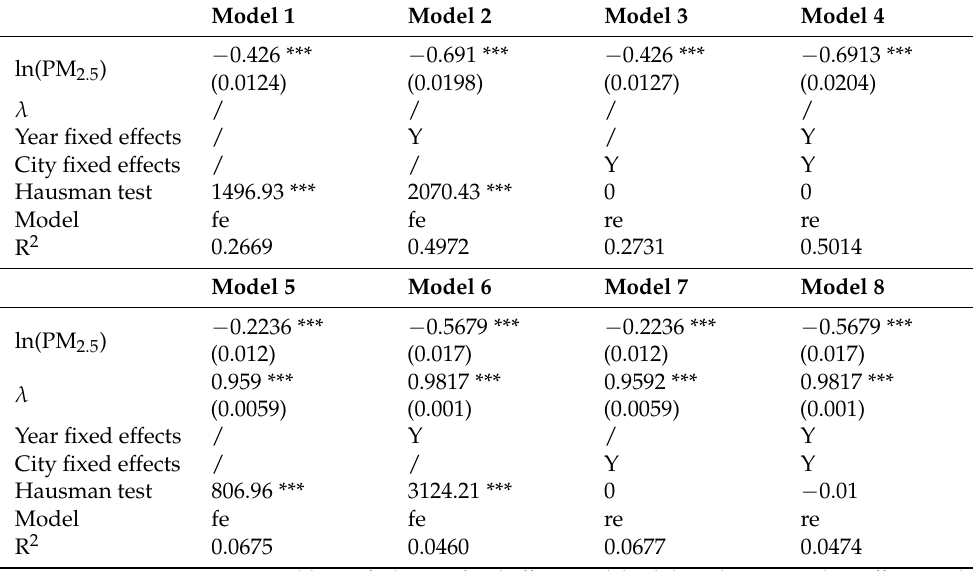
Table 3. Temporal convergence based on sampled PM 2.5